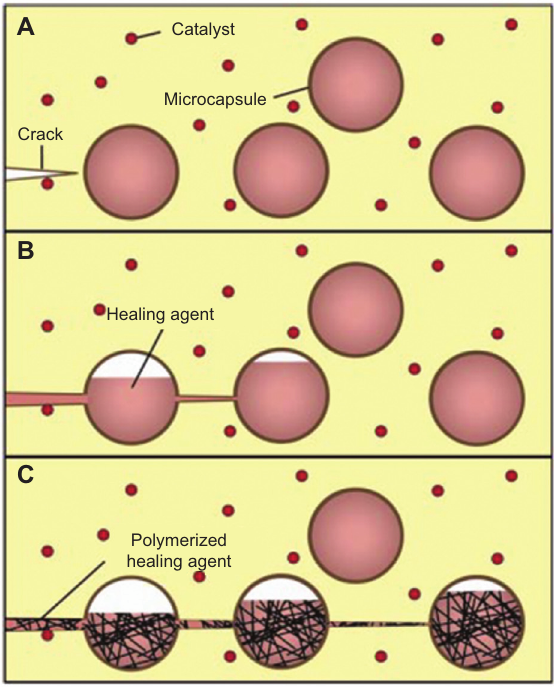
Figure 6 Schematic diagram of the self-healing concept using microcapsules with a healing agent inside and a catalyst embed- ded. in the material. (A) Before appearance of the crack, (B) after appearance of the crack, and (C) after healing (reprinted with permission from [35]). Copyright 2001, Macmillan Publisher Ltd: Nature.